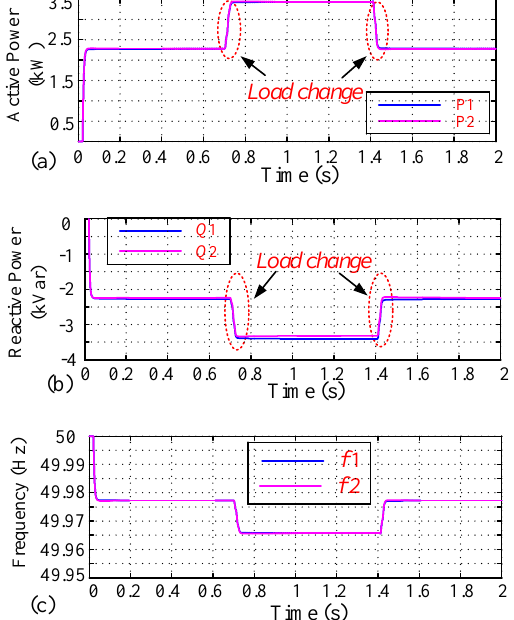
Figure 12. Simulation results in Case E: ( a ) active power; ( b ) reactive power; and ( c ) frequency. 6.6. Case F: Validity of Conventional Droop Control in Highly Resistive Line of AC Microgrid